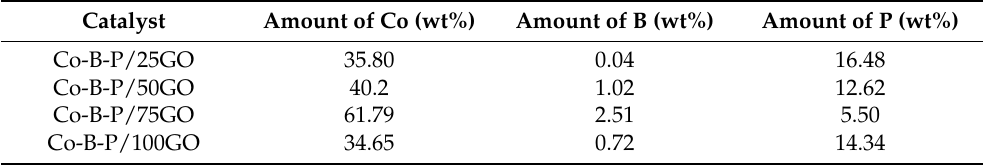
Figure 8. Hydrogen volume versus reaction time for the as-prepared catalysts ( a ); the histogram of the H 2 generation rate versus the additive amount of GO ( b ) (batch system, 25 ◦ C, 1.5 wt% NaBH 4 + 5 wt% NaOH, 0.1 g catalyst). Table 3. The chemical composition of the prepared catalysts with different amounts of GO were determined by